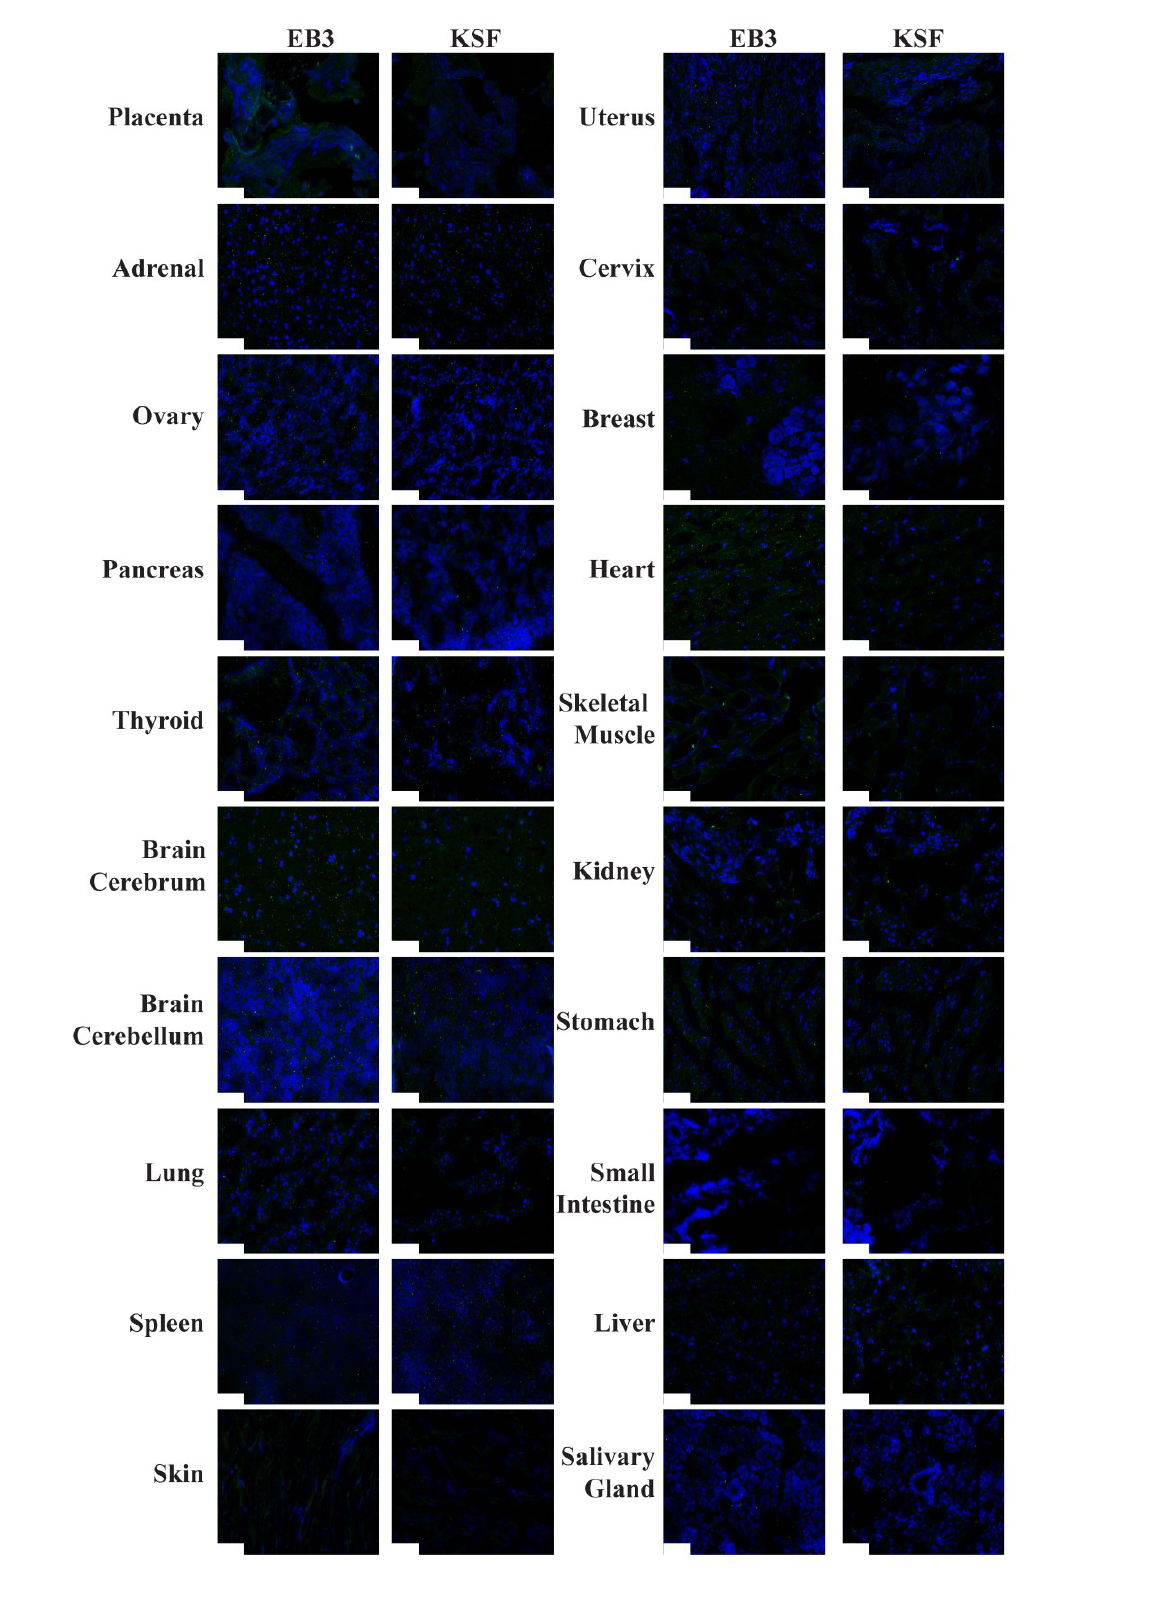
Figure 3. Immunofluorescence staining of human healthy tissues using small immune protein antibody formats SIP(KSF) and SIP(EB3). SIP antibodies are shown in green as they were detected using anti-human-IgE IgG antibody, which was further detected by Alexa Fluor 488 goat anti-rabbit IgG antibody. Cellular nuclei were stained with